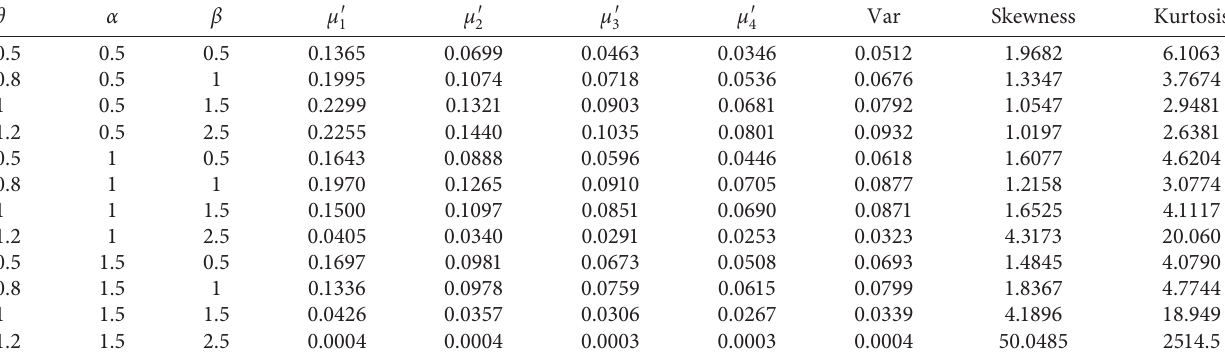
Table 1: Moments for some selected valued